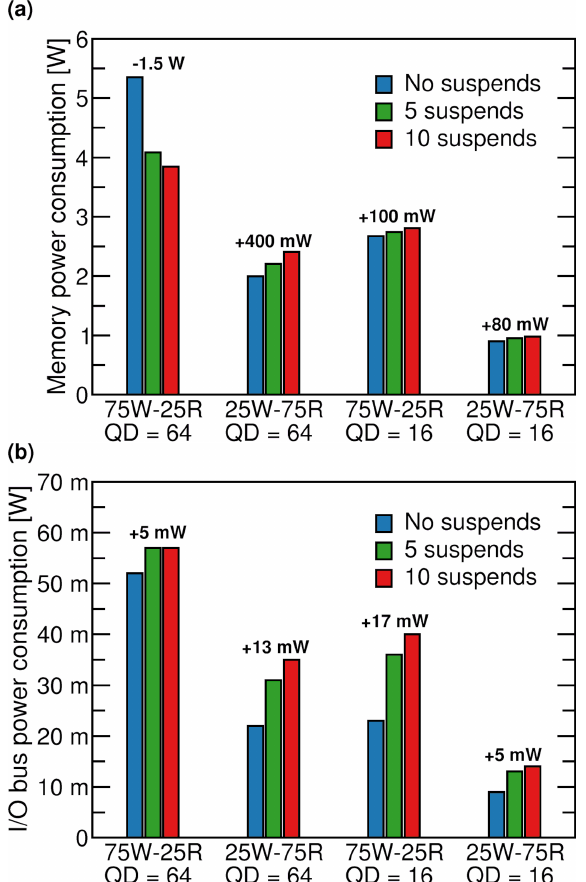
Figure 11. ( a ) The power consumption of the memory sub-system in the SSD. ( b ) The power consumption of the internal I/O bus in the